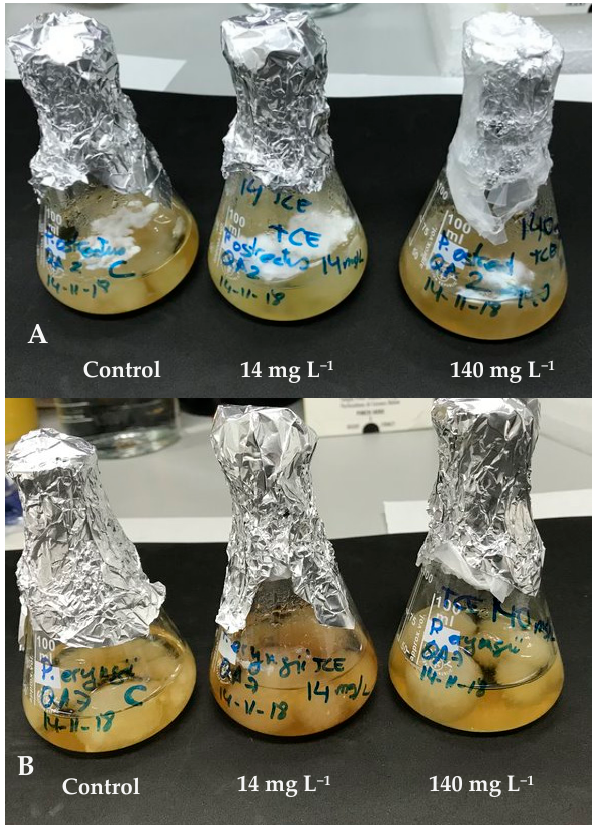
Figure 1. Pellets of Pleurotus ostreatus ( A ) and Pleurotus eryngii ( B ) growing in liquid broth without (control) and with trichloroethylene (TCE) at 14 and 140 mg L − 1 . On the contrary, the hyphae of P. eryngii seemed to maintain their morphological structure and appeared unaffected by the presence of the pollutant at any concentration (Figure 2E,F) exhibiting the same the tubular structure both in the presence or absence of TCE.